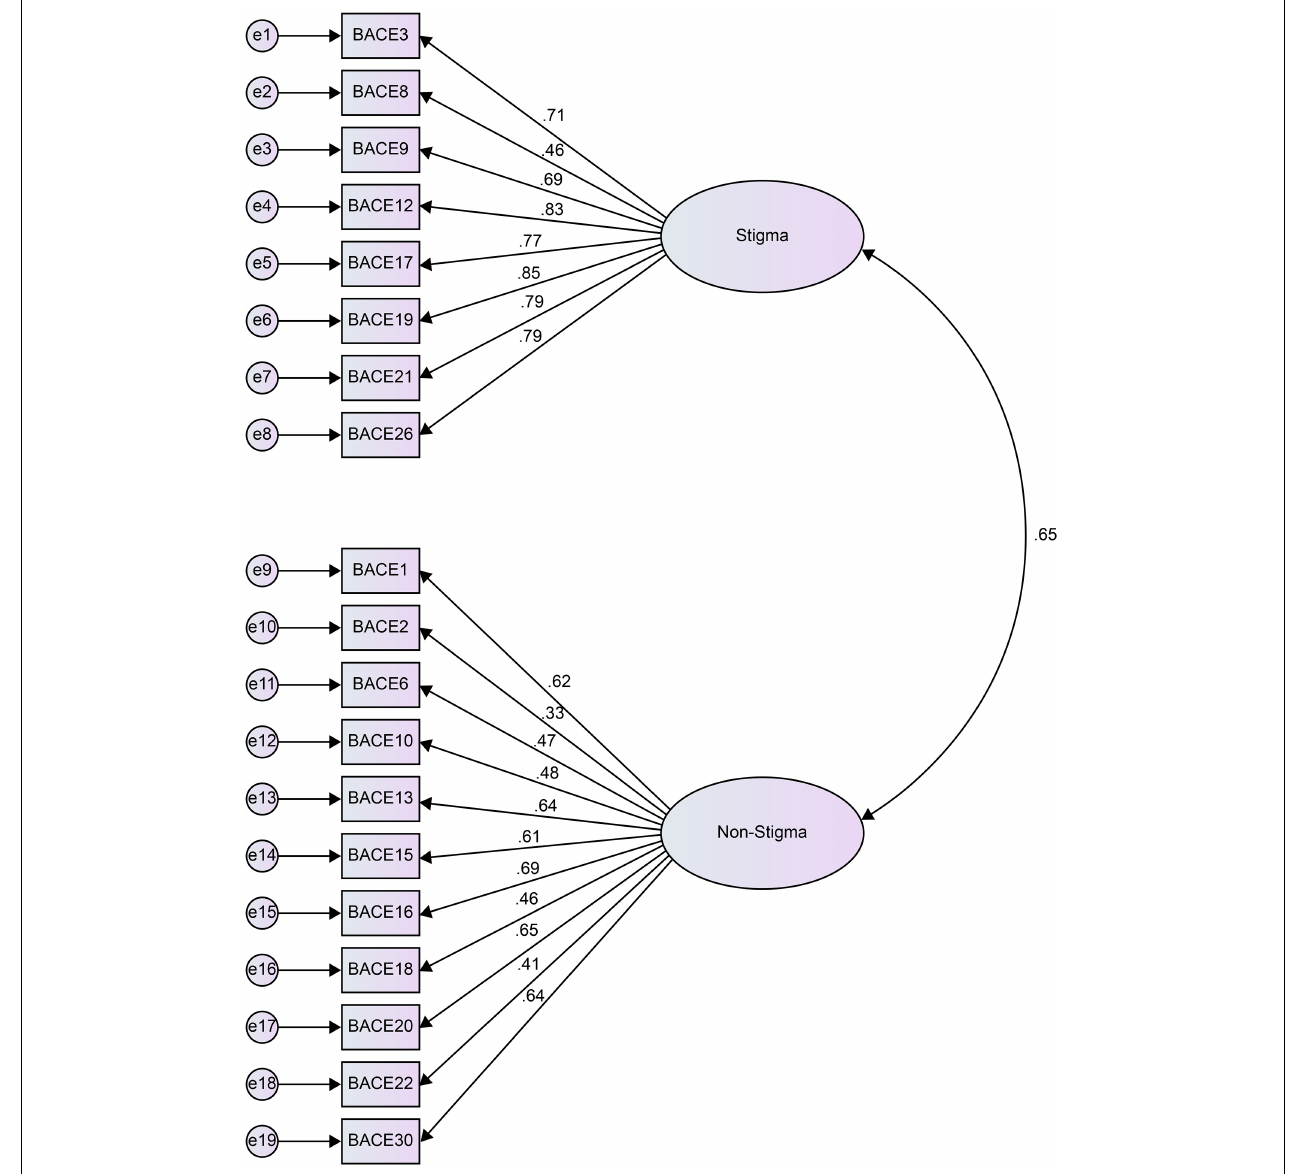
FIGURE 1 | Result of the confirmatory factor analysis of the Japanese version of the BACE